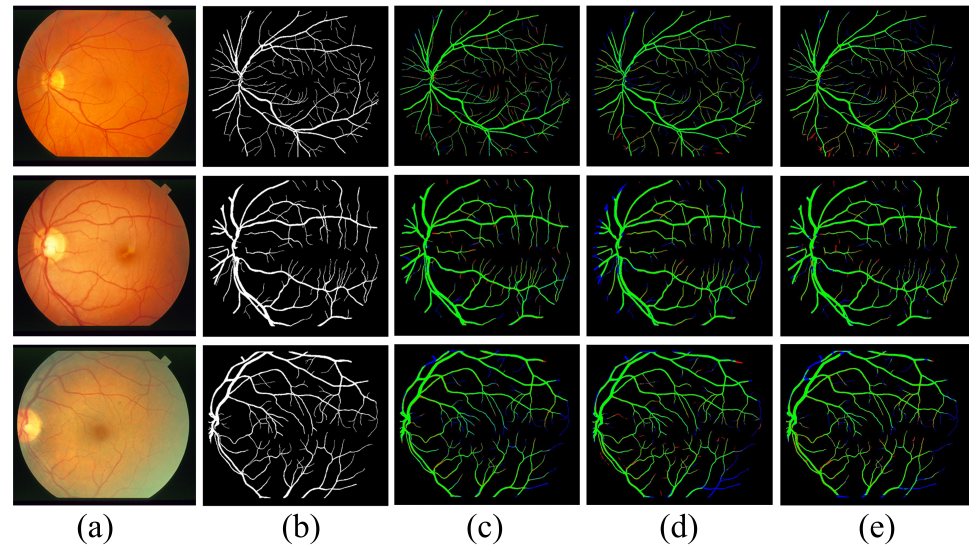
Figure 5. Analysis of segmented output. The segmentation maps’ black and green colours represent accurately predicted pixels, whereas the blue and red colours represent false negatives and false positives, respectively: ( a ) noisy test images of STARE dataset; ( b ) corresponding ground truth images marked by Adam Hoover; ( c ) the output of SegNet [48]; ( d ) the output of U-Net [49]; ( e ) the output of the proposed G-Net light architecture. Table 4. Comparison results on the STARE dataset. Red is the best, green is the 2nd best, and blue is the 3rd